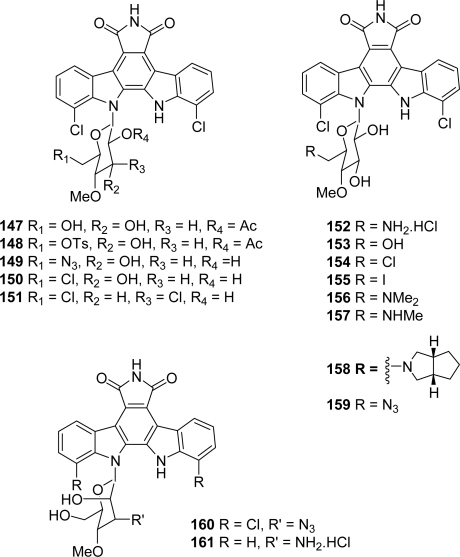
Rebeccamycin analogues bearing different substituents on the sugar moiety.